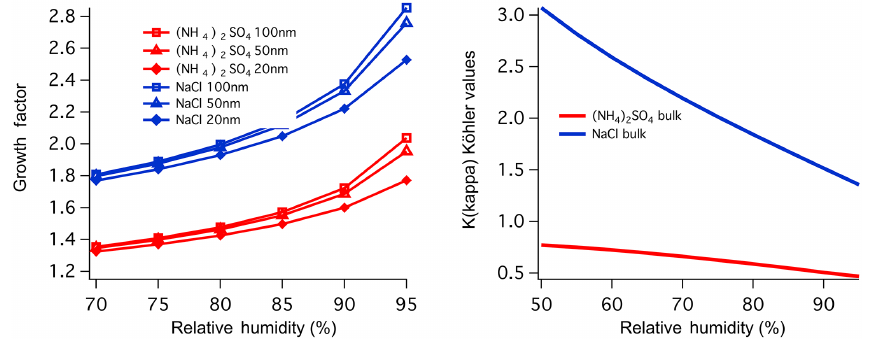
Figure 5. (Left panel) growth factor predictions for (NH 4 ) 2 SO 4 and NaCl particles of size 100, 50, and 20nm diameter. (Right panel) K(kappa)–Köhler value predictions for (NH 4 ) 2 SO 4 and NaCl particles as a function of RH. All simulations use the AIOMFAC activity coefficient model.